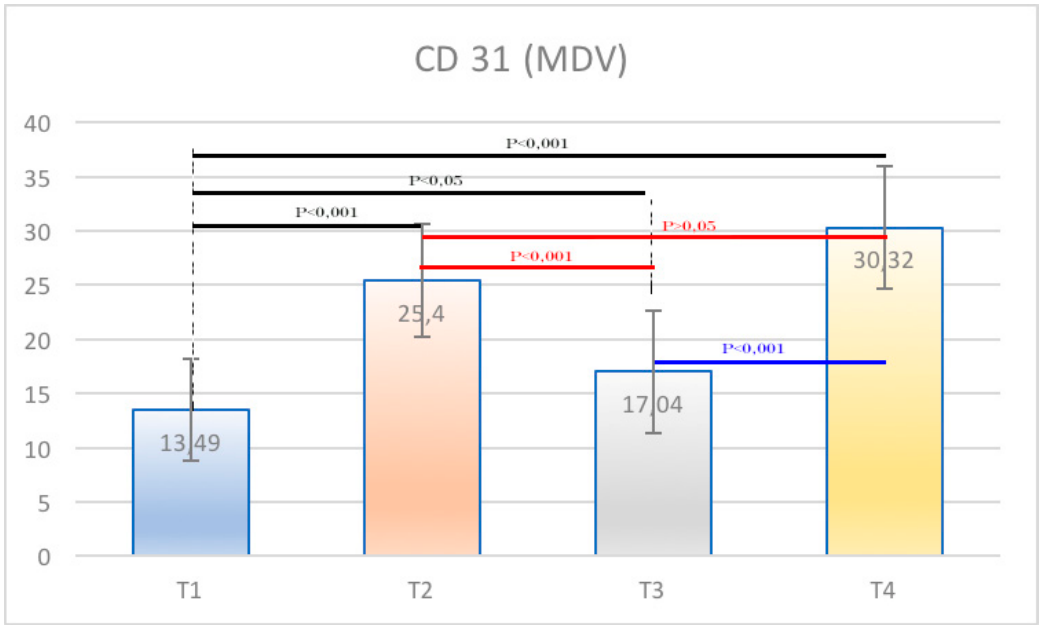
Figure 9. Graphical representation of different CD31 expression. Statistical significant differences between groups were find. MDV—microvessel density.